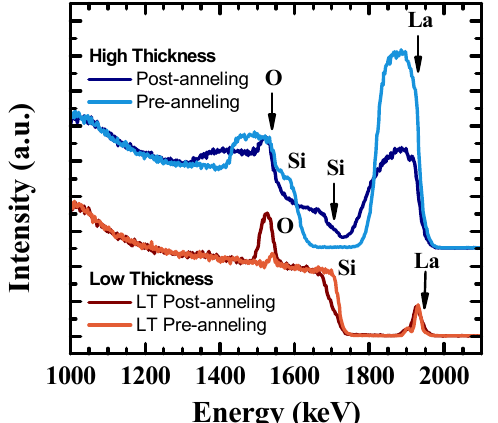
Figure 2. Comparison between pre/post-annealing and high/low-thicknesses Rutherford backscat- tering spectroscopy spectra of Nd-doped lanthanum niobate sputtered thin films. For the post-an- nealed sample with high thickness, the Si edge placed at the 1725 keV channel originates from the Si taking part of the mixed top later, showing its concentration depth profile, whereas the Si edge at the lower-energy 1625 keV channel is associated with the Si substrate.